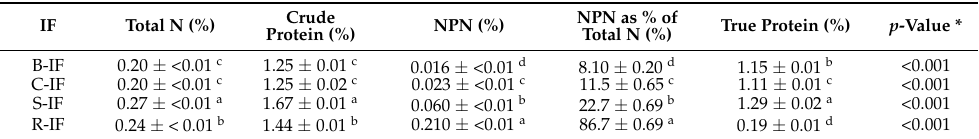
Table 1. Total nitrogen (N), crude protein, non-protein nitrogen (NPN), and true protein of infant formulae (IF) samples; B-IF (bovine IF), C-IF (caprine IF), S-IF (soy IF), R-IF (rice IF). Data are presented as mean of triplicate independent replicates (% w / v ) ± standard